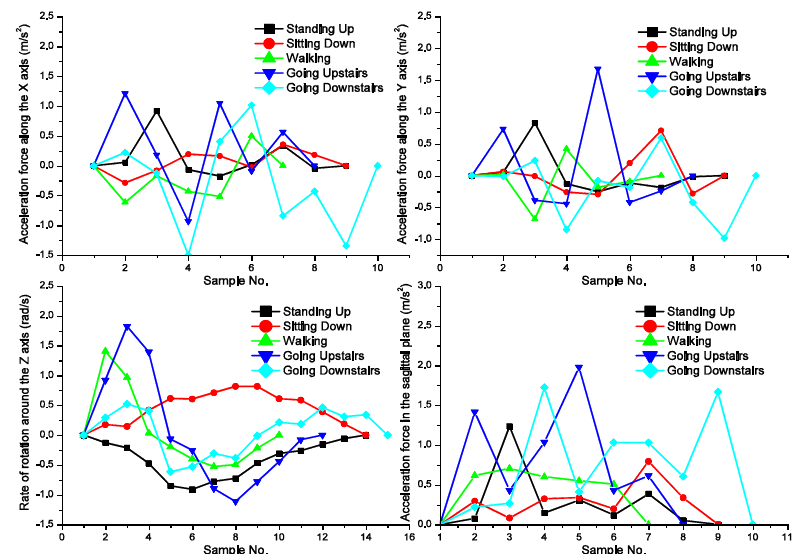
Figure 2. Sensed accelerations and velocity of each gait cycle.